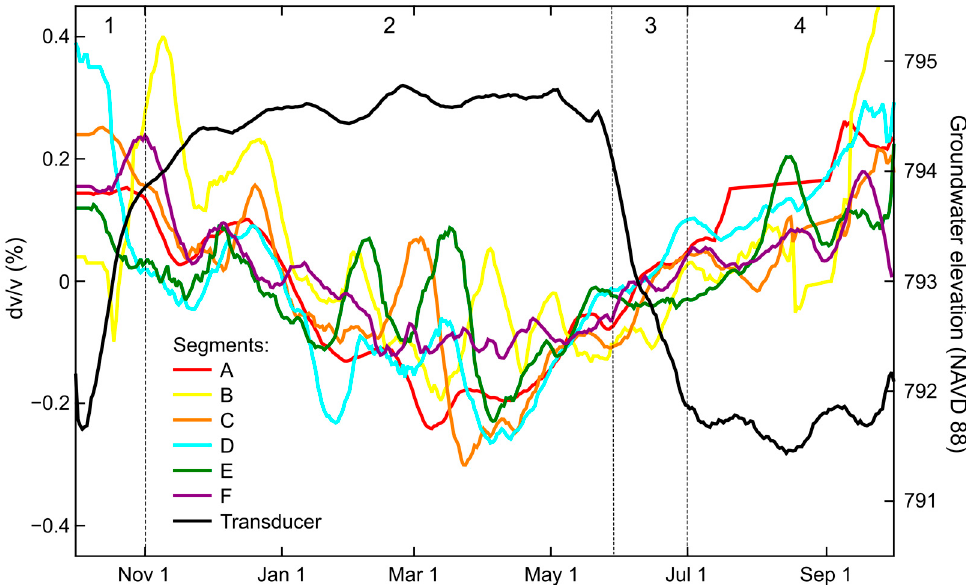
Figure 6. Changes in seismic velocity (dv/v) at each network segment (Figure 5) and groundwater elevation recorded by the well transducer. Temporal periods (1–4) are seasonal divisions used to develop correlations between dv/v and groundwater changes for each seasonal period.